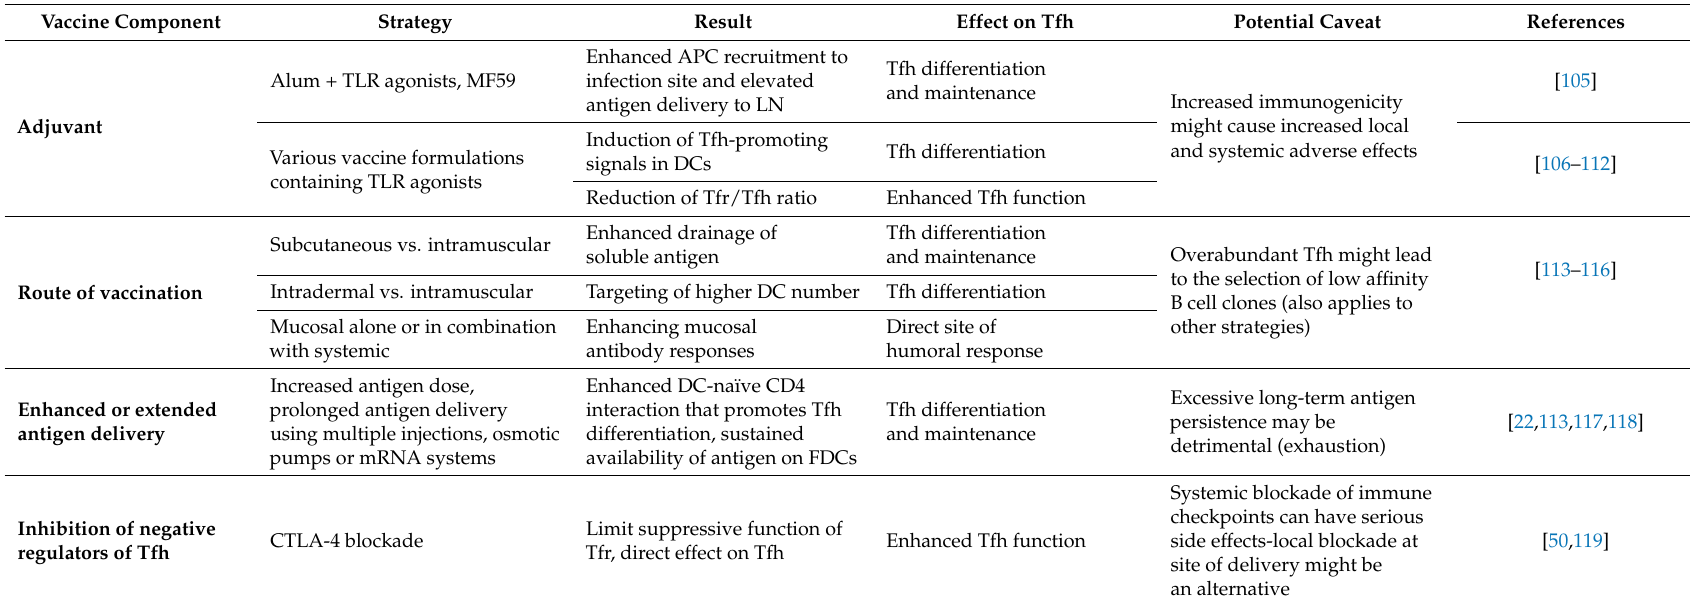
Table 3. Summary of strategies to enhance Tfh